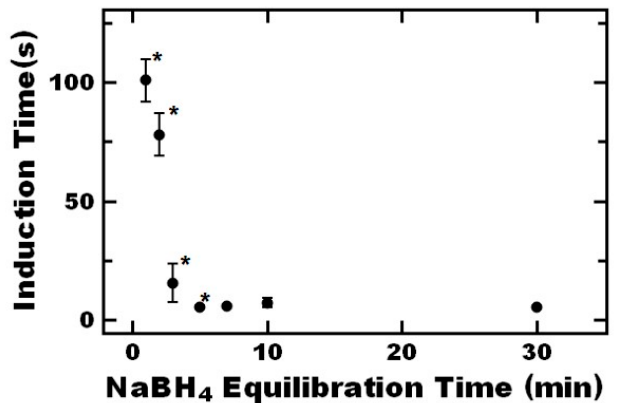
Figure 4. The effect of sodium borohydride equilibration on the induction time of the 4-nitrophenol reaction. Standard reagent concentrations of 0.01 mM and 0.01 M were used for 4-nitrophenol and sodium borohydride, respectively. Data points marked with an asterisk (*) are significantly different than each other ( p < 0.1).